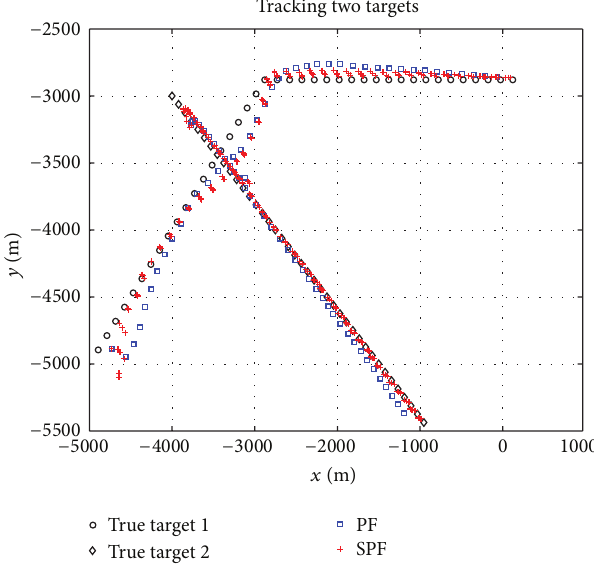
Figure 13: Range errors during each iteration (one trial).